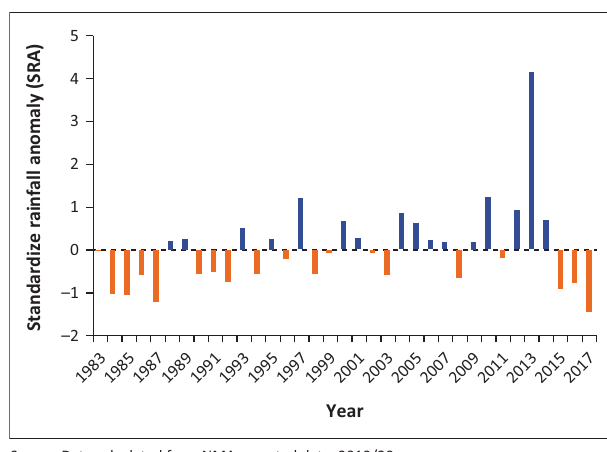
FIGURE 3: Anomaly of annual rainfall at Harshin from 1983 to